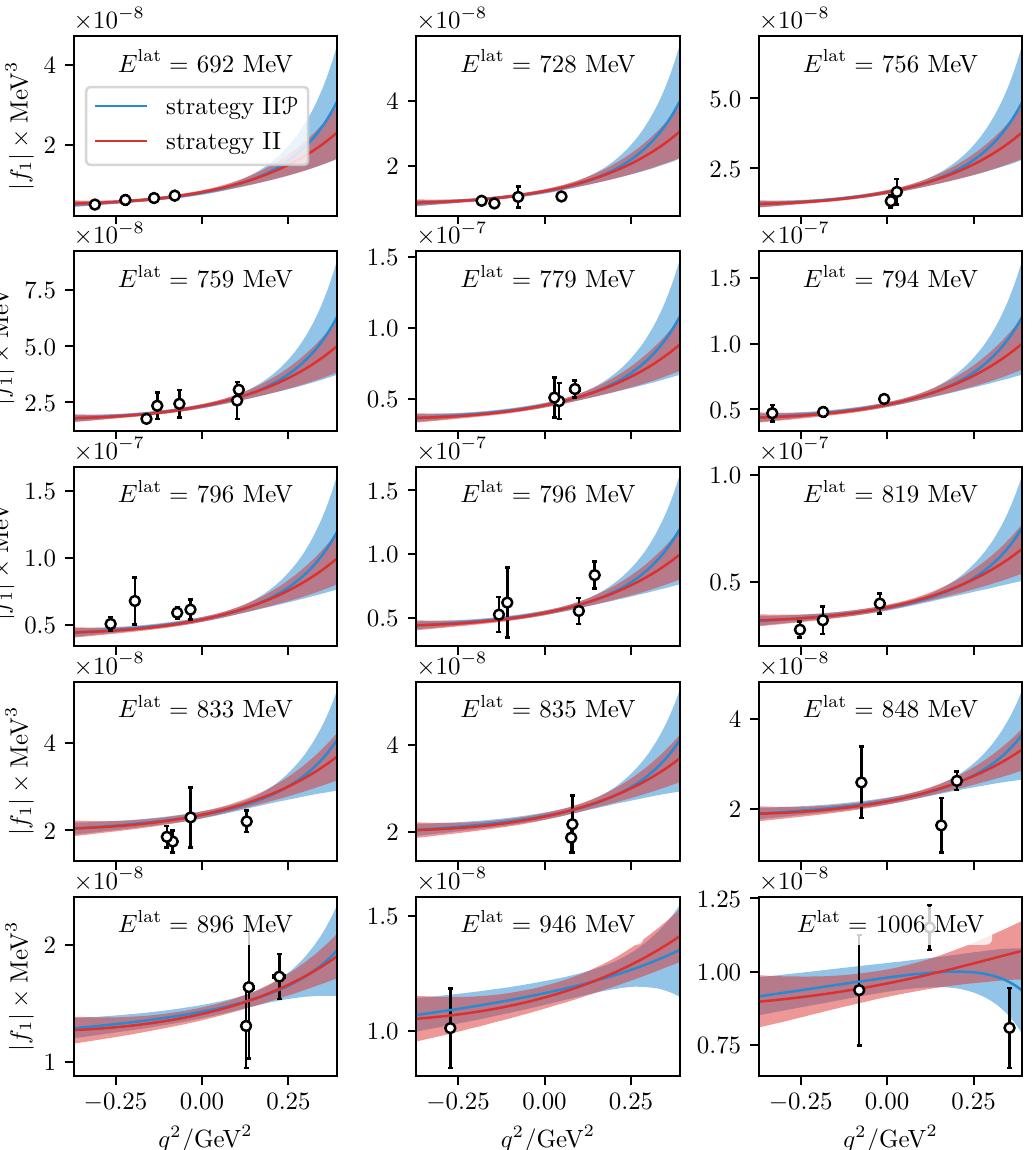
Figure 2. The results of two fit strategies in comparison with the γπ lattice data of ref. [18] at M π ≈ 317 MeV . Shown are slices of constant energy. For convenience, the results are displayed in physical units, but the fit is carried out in lattice units, thus the error bands represent the statistical error